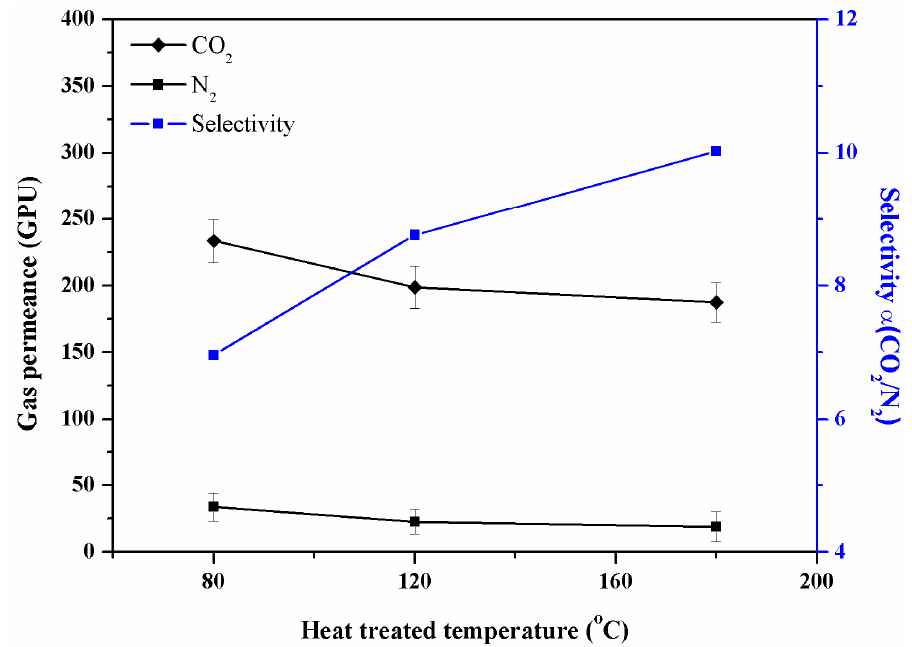
Figure 8. The gas permeance/selectivity of heat-treated composite membrane CS4 at 1 bar.